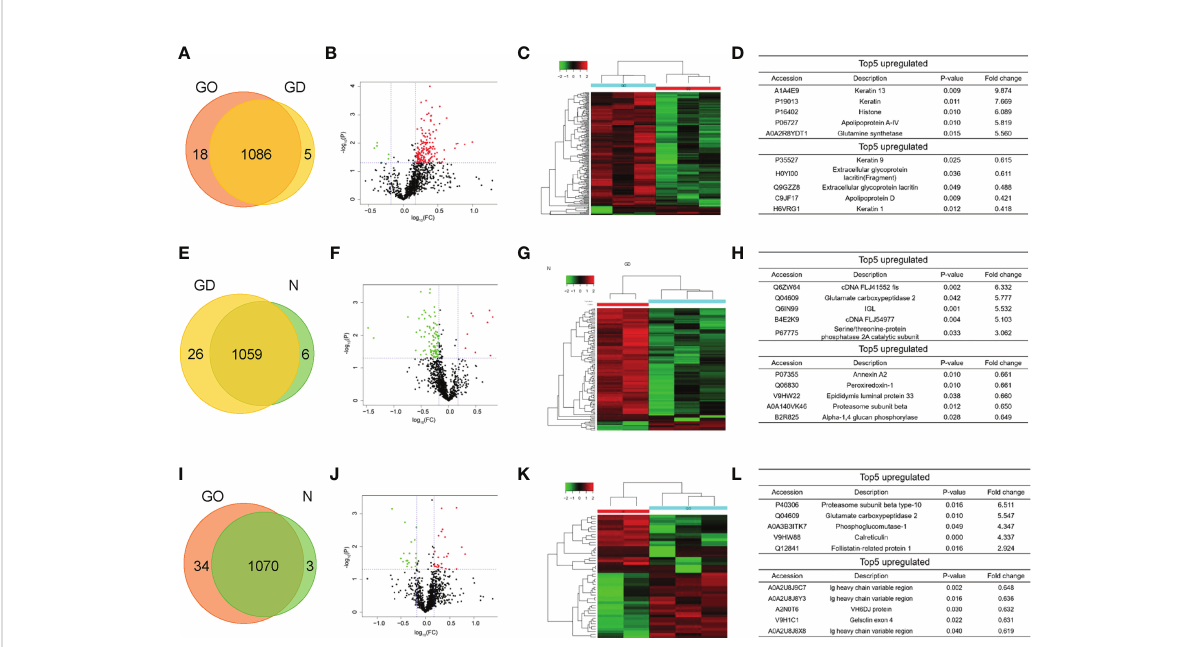
FIGURE 2 Pairwise comparison of the differentially expressed proteins in exosomes among the three groups. (A, E, I) Venn diagram comparing the number of identi fi ed proteins between GO and GD, GD and controls, GO and controls. (B, F, J) Volcano plots showing the differentially expressed proteins in exosomes between the GO group and the GD group, between the GD group and the healthy control group, and between the GO group and the healthy control group. A fold change of 1.5 and a p < 0.05 were used as the cutoff points. Upregulated proteins are shown in red, and downregulated proteins are shown in green. (C, G, K) Clustering heatmaps of differentially expressed proteins in exosomes from the three groups as described above. (D, H, L) List of the top 5 upregulated and downregulated proteins among the differentially expressed proteins from the three groups described